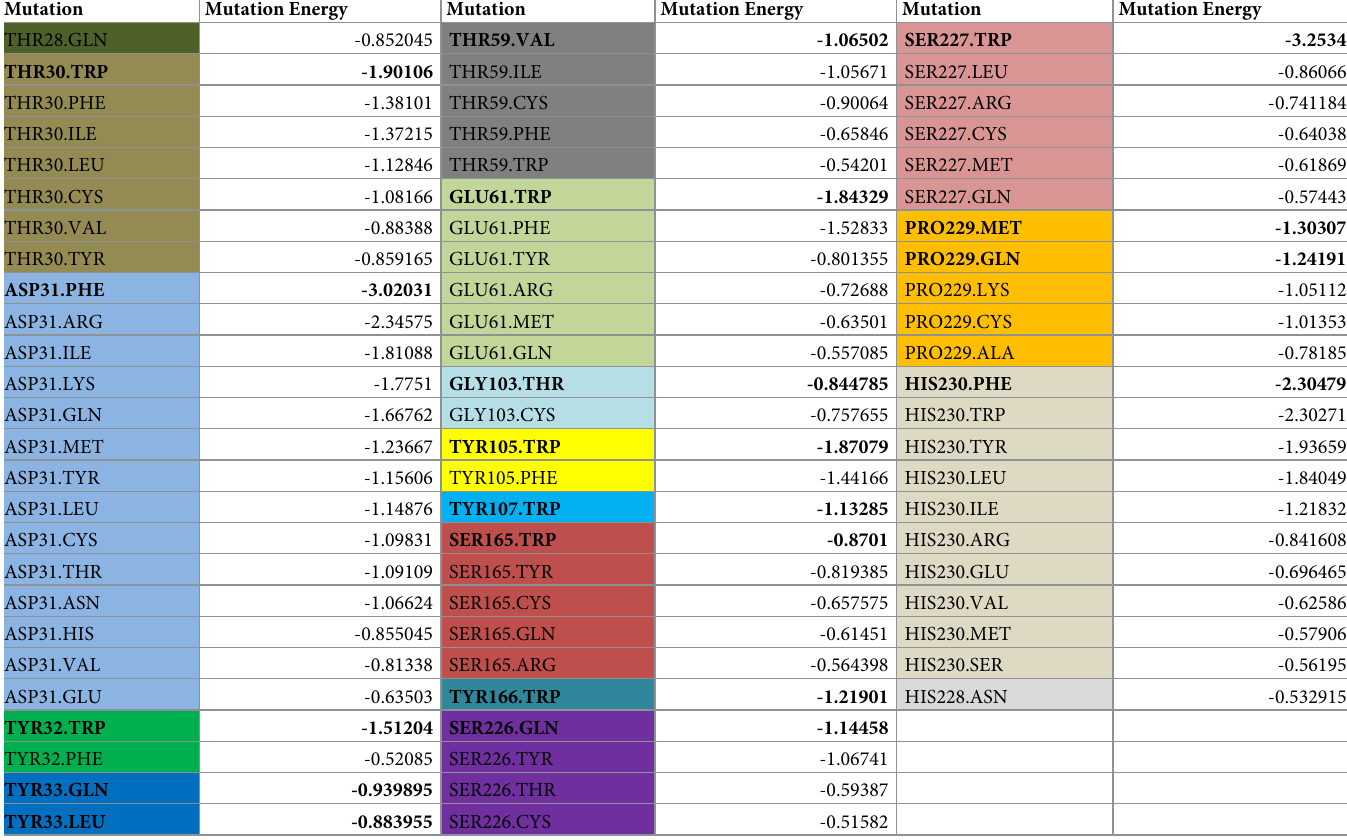
of which the beneficial mutations that were positive for scFv-FuBc binding were shown in the Table 2 . Interestingly, we noticed that multiple beneficial mutations were present at certain positions with highly negative mutation energy suggesting the stabilizing interactions. These Table 2. All possible beneficial mutations for scFv protein that improves its binding to